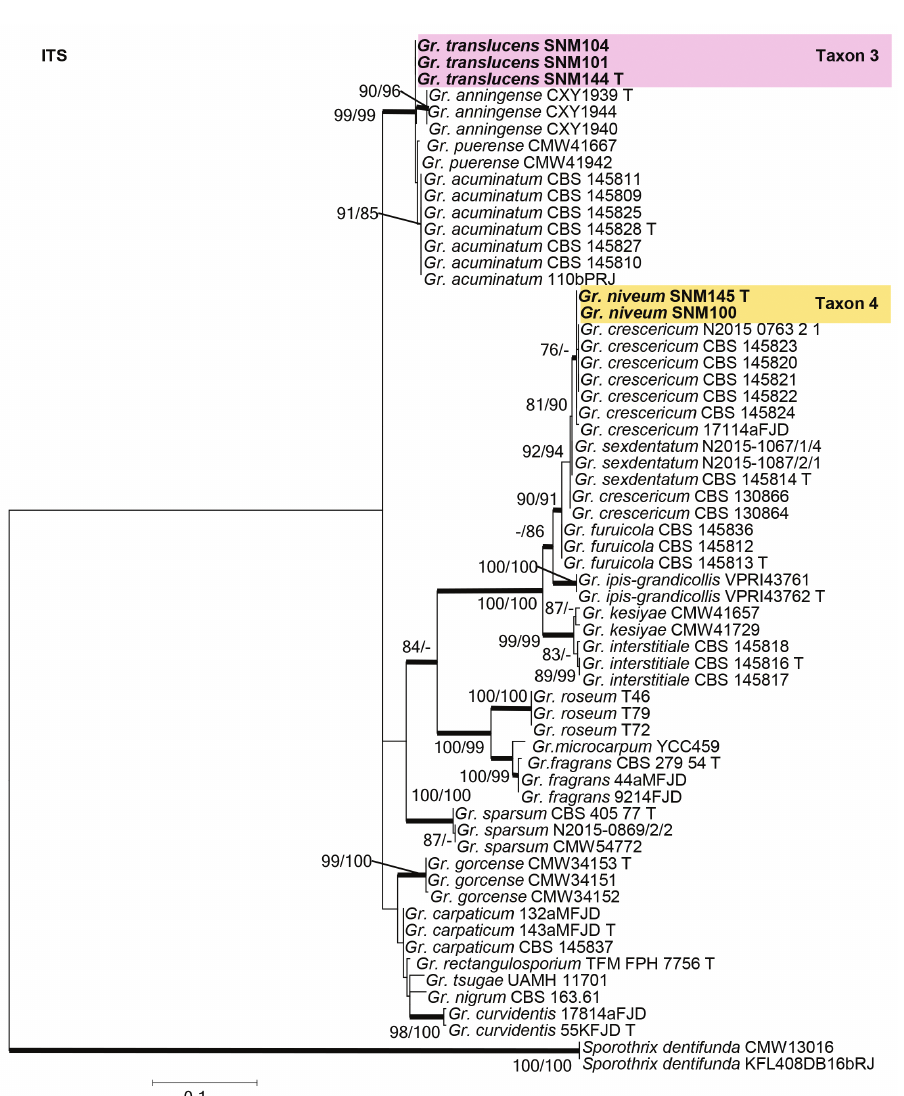
Figure 3. Maximum likelihood phylogeny of Graphilbum using complete ITS region. The isolates recovered in this study are highlighted in color and in bold font. ML and MP bootstrap support values ≥ 75 are indicated at the nodes as ML/MP. Bold branches indicate posterior probabilities values ≥ 0.9. T indicates ex-type